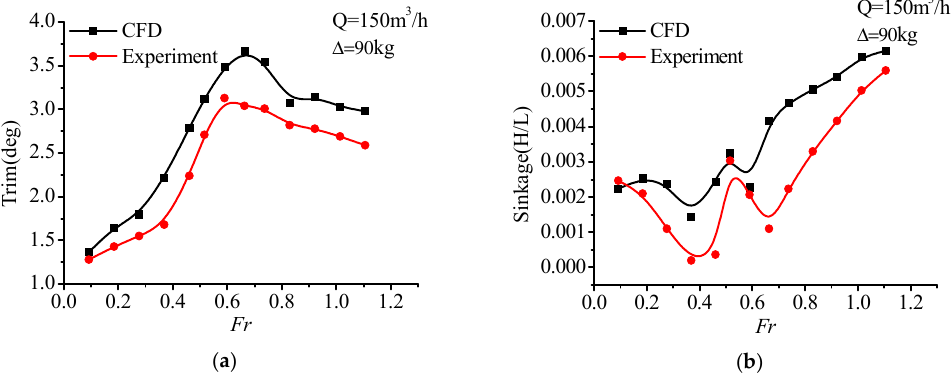
Figure 18. Motion attitude curves of CFD and experiment: ( a ) Trim angles curves; ( b ) Sinkage curves ( Δ = 90 kg, Xgm = 150 mm, Q = 150 m 3 /h).